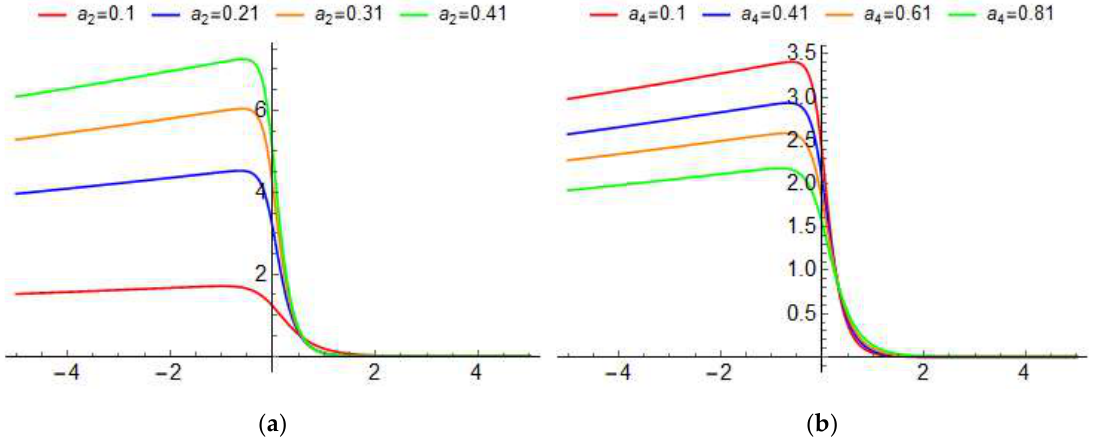
( 𝑥, 𝑡 )(cid:3627) in (33) where 𝑡 = 0.5,𝑎 4 𝑎 = 0.1 4 and 2